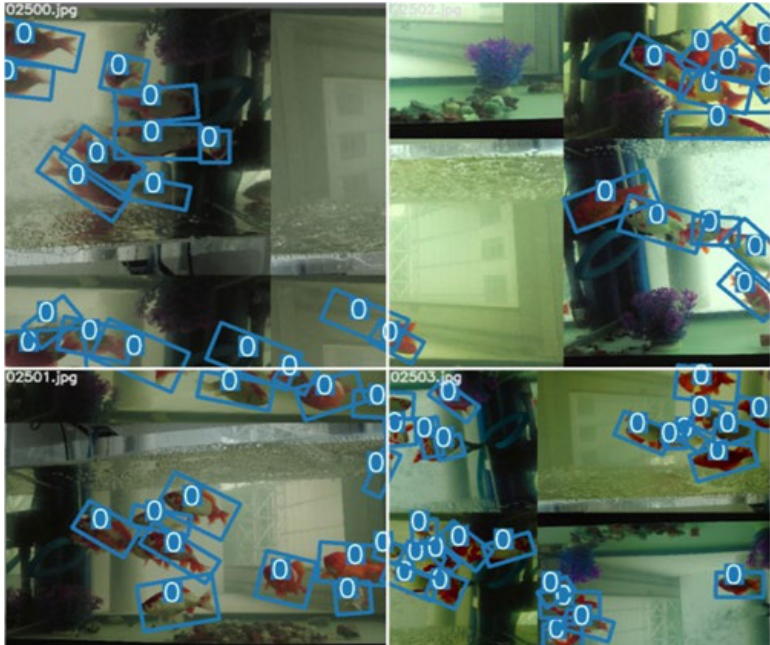
Figure 12. The image after the Mosaic operation of the raw image was used for model training. The image above shows a total of four images that have gone through the Mosaic operation. Each image is stitched together from four randomly selected images from the dataset. The blue box is the detection box.